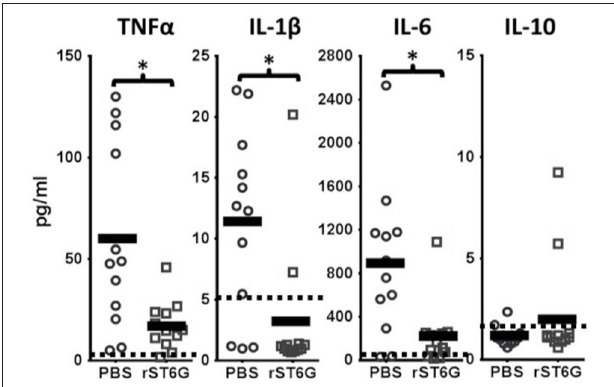
FIGURE 5 | Inflammatory cytokine release during acute airway inflammation is suppressed by rST6G infusion. C57BL/6 wild-type animals were challenged with NTHI and subjected to the rST6G or sham (PBS) treatment protocol as outlined in Figure 4A . The bronchial alveolar lavage fluids (BALF) were analyzed for cytokines by Luminex 100 multiplex assays. Dashed lines and the shaded boxed regions represent the reliable lower assay limit of detection for each cytokine. Many of the values obtained, especially for the IL-10 assays and the rST6G-treated cohorts for IL-1 β values, were zero. For these, a default low value of “1” was assigned in order to calculate the p value. * p <